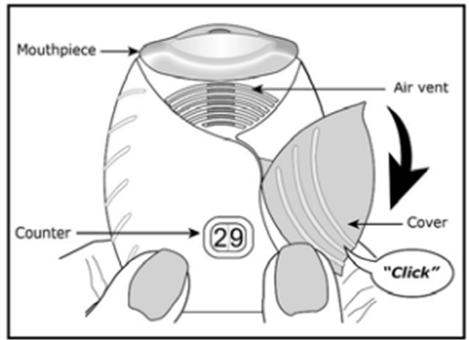
Figure 3. Diagram of Breo Ellipta ® [32].